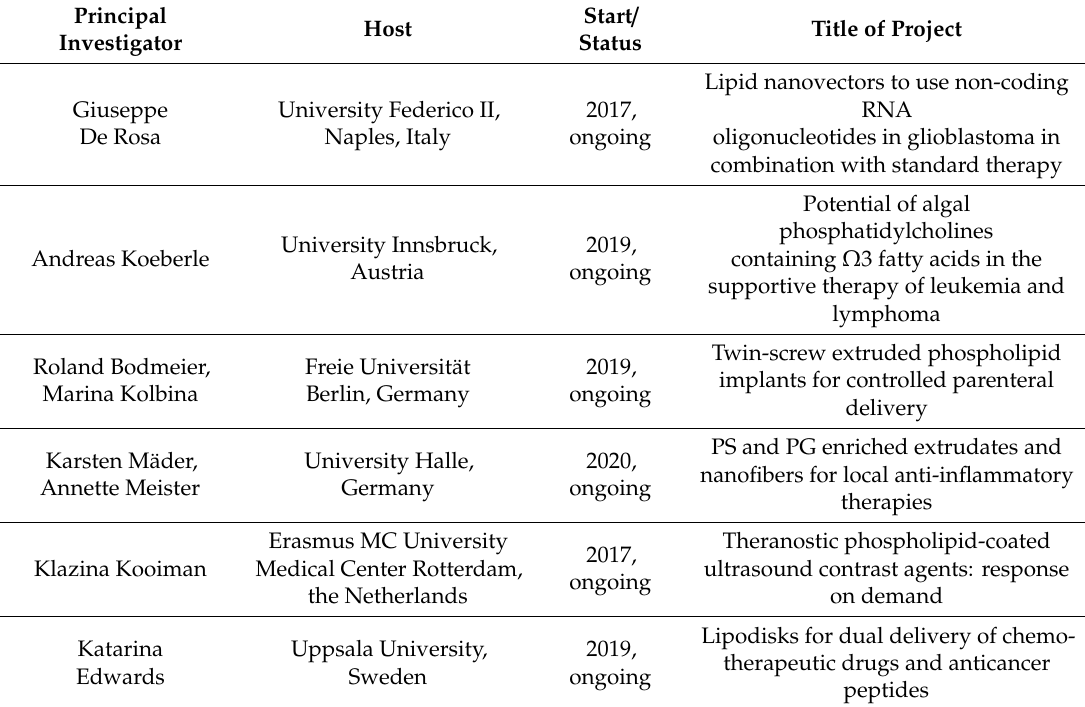
Table 4. Overview of PRC-funded research projects (2017–now) covering the parenteral use of lipid-based formulations but excluding the use of